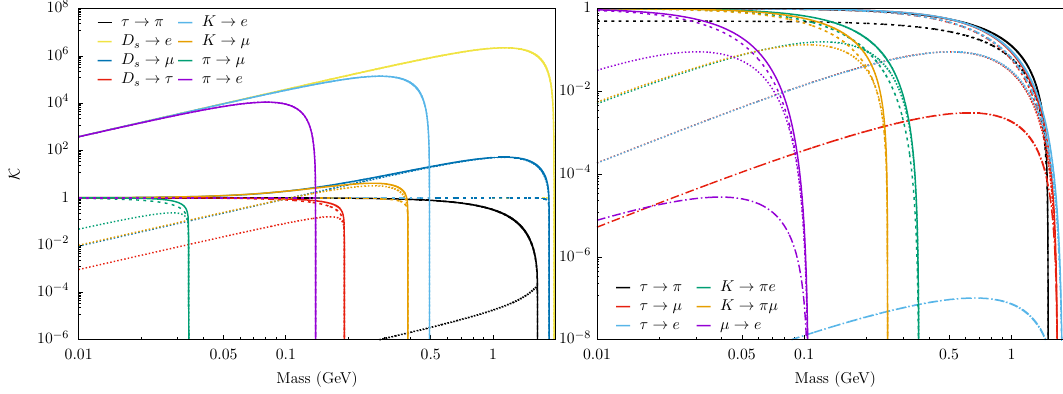
Figure 2 . The scale factors separated by helicity components are shown. In two-body decays (left), the h = (cid:0) 1 components (dashed) for all channels do not depend on the mass. The enhancement is driven by the h = +1 components (dotted), which are the dominant contribution of the unpolarised factors (solid). In three-body decays (right), there are two di(cid:11)erent scale factors for purely leptonic decays, noted as ‘ (cid:11) ! ‘ (cid:12) : if the decay is mediated by j U (cid:12)N j 2 , for which the h = (cid:0) 1 (dashed) and the h = +1 (dotted) components are comparable, and if the decay is mediated by j U (cid:11)N j 2 , for which h = (cid:0) 1 dominates over the h = +1 (dotdashed). In both cases, the two parts sum up to the same quantity (solid). The kaon decays are also divided in h = (cid:0) 1 (dashed) and h = +1